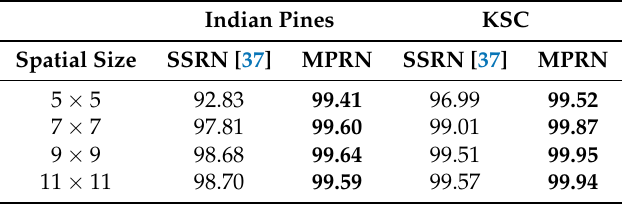
Table 10. Overall accuracy (%) obtained by the proposed MPRN and the spatial-spectral ResNet (SSRN) [37] method when considering different input spatial patch